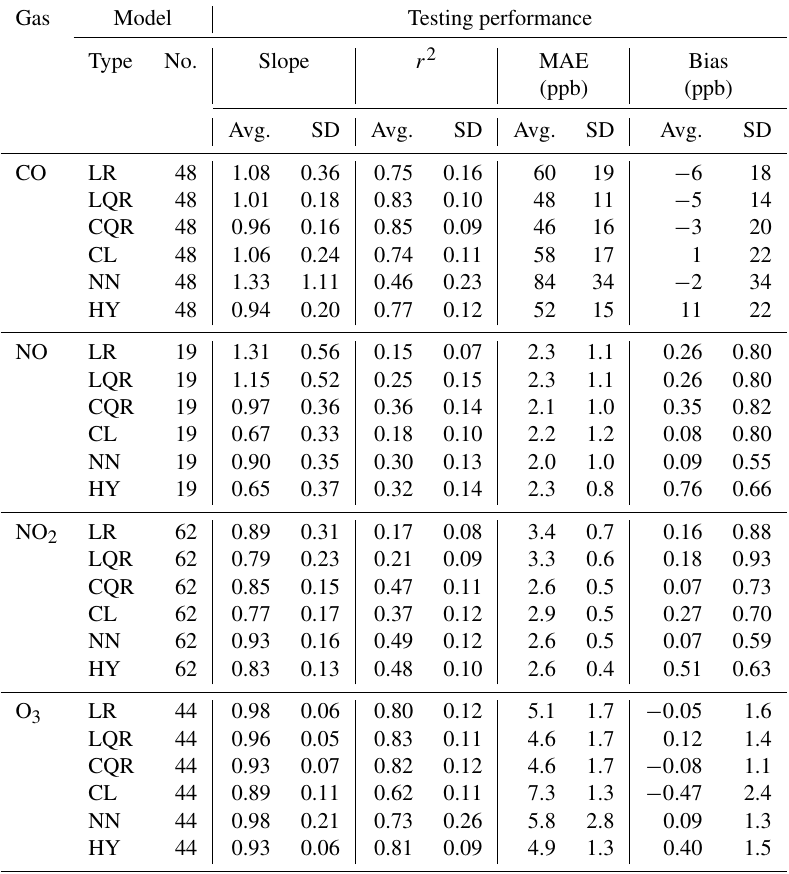
Table 5. Performance data for iRAMP models at CMU in 2017 (Avg. is the average; SD is the standard deviation). The “No.” sub-column under “Model” indicates the total number of iRAMP models developed for each gas. Slope and r 2 are presented for the best-fit line between the calibrated RAMP measures and those of the regulatory